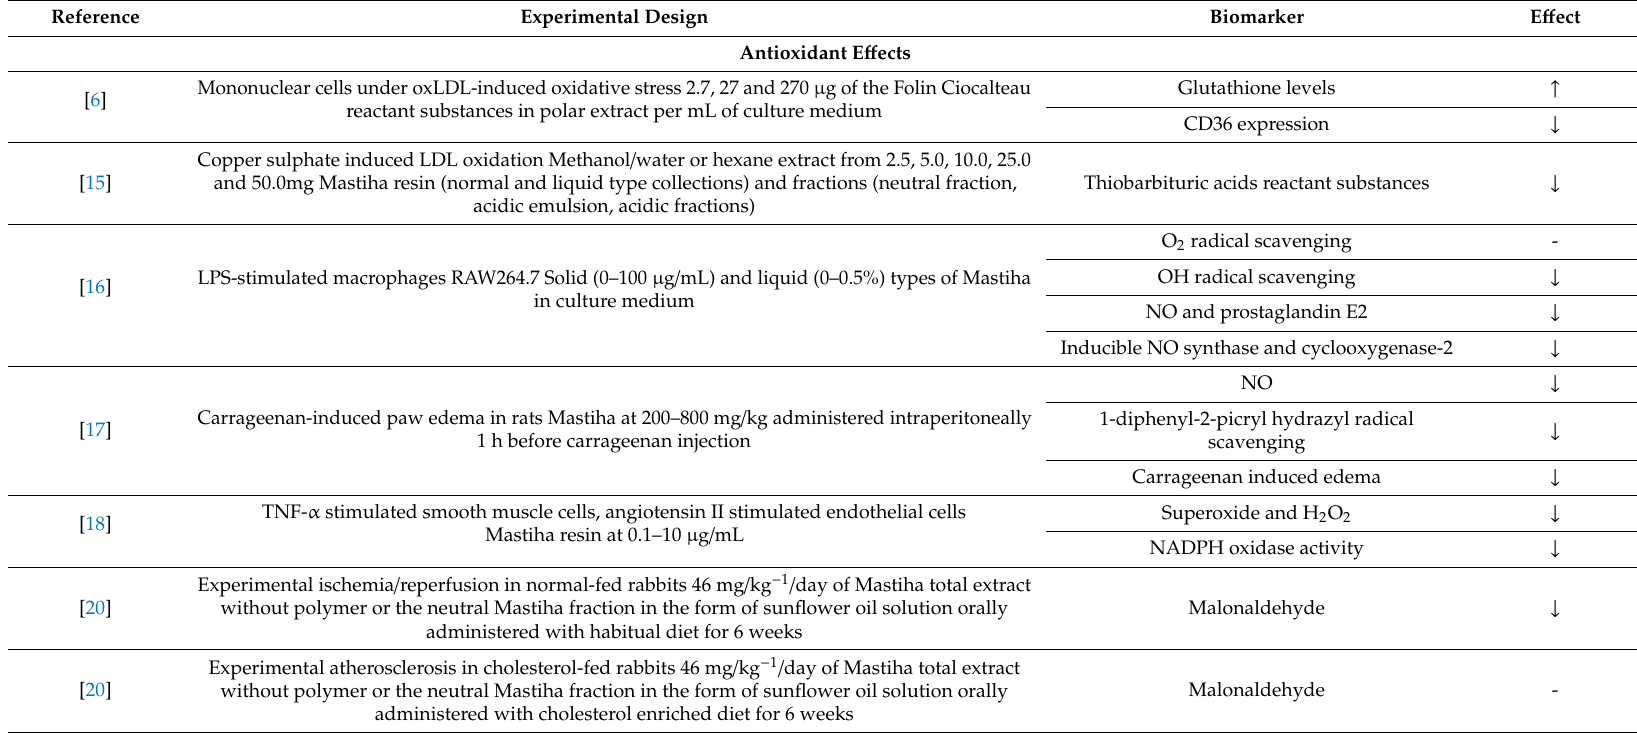
Table 1. Preclinical evidence of the antioxidant and anti-inflammatory e ff ects of